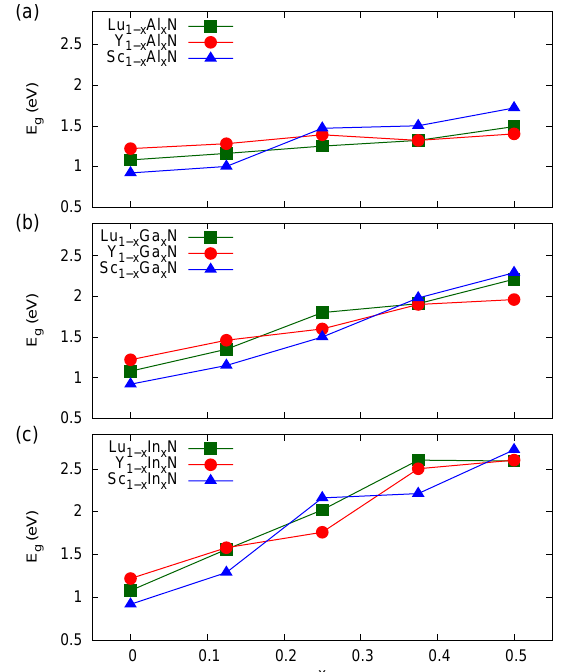
Figure 2. Band gaps calculated (MBJLDA) for rock salt alloys ( a ) RE 1 − x Al x N, ( b ) RE 1 − x Ga x N, ( c ) RE 1 − x In x N, where RE = Sc, Y, and